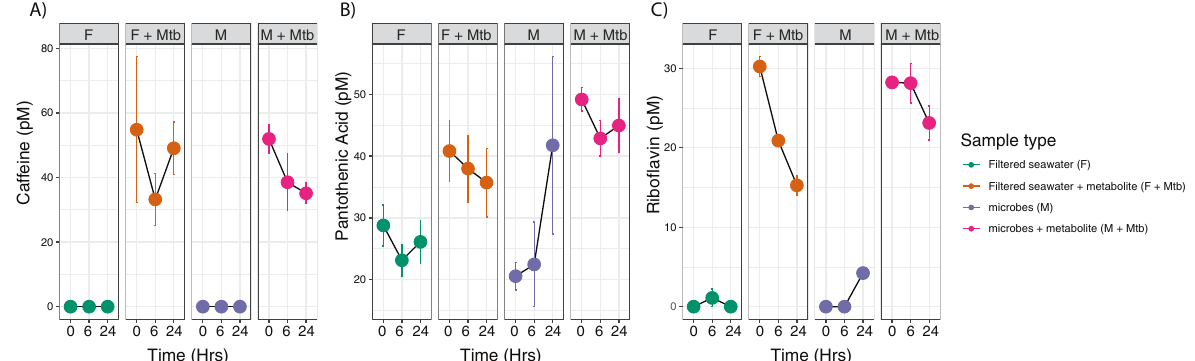
Fig. 6 Concentrations of caffeine, pantothenic acid, and ribo fl avin exhibit different trends in the presence or absence of reef seawater microbial communities overtime. Variations in A caffeine, B pantothenic acid, and C ribo fl avin concentrations overtime show that metabolites experience different trends in the presence/absence of reef seawater microbial communities. Color corresponds to sample type, symbols represent average cell counts across replicates, and error bars re fl ect standard error computed across replicates.